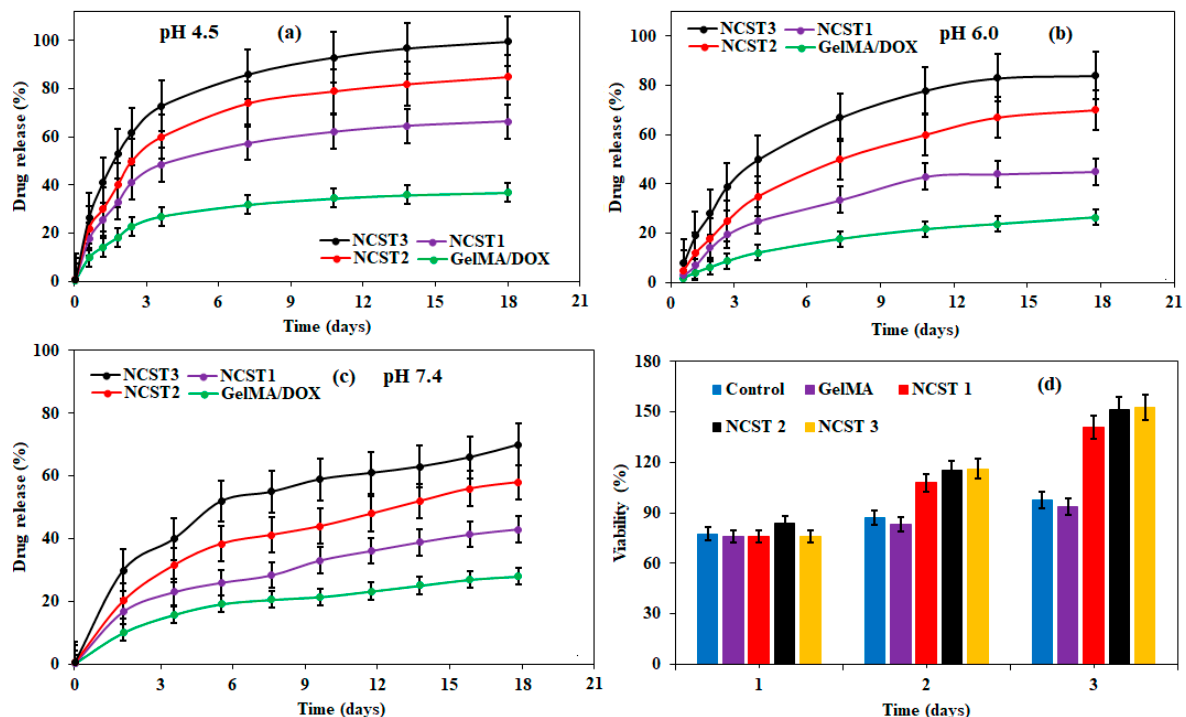
Figure 5. Stimuli-responsive drug release of DOX loaded GelMA, NCST1, NCST2, and NCST3 hydrogels at ( a ) pH 4.5, ( b ) pH 6.0, and ( c ) pH 7.4, respectively. ( d ) Cell viability of hydrogels with human fibroblast cells. 56.1%, and 66.9% of drug release, respectively (Figure 5c). It is attributed that DOX mole-